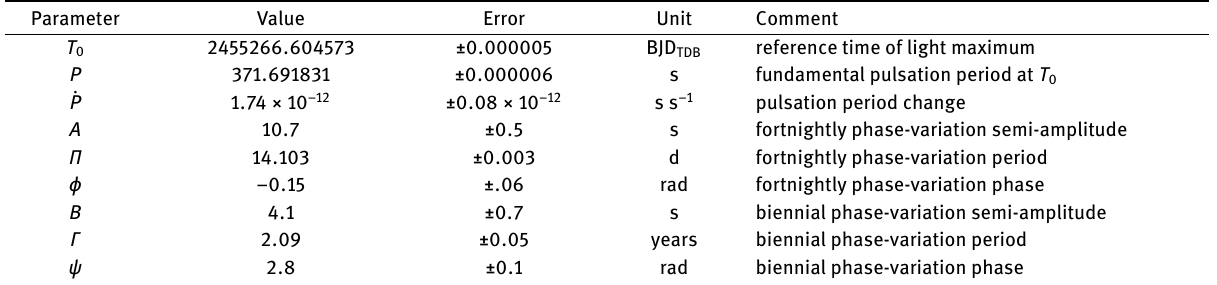
Table 1. Ephemeris parameters for the times of light maxima presented in Equation 3, derived from eight years of pulse timing measure- ments. The fortnightly variation refers to reflex motion of the sdB from the M dwarf, while the biennial variation refers to the reflex motion of the inner sdB+dM binary due to a potential circumbinary